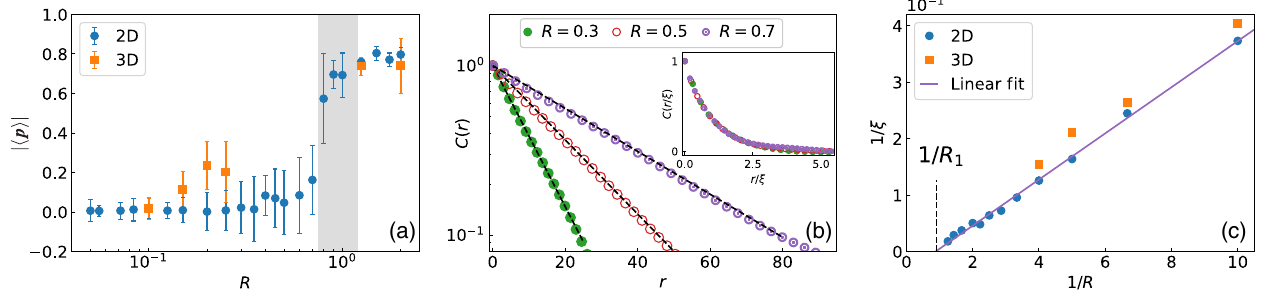
FIG. 5. (a) Variation of the order parameter jh p ij with R for our 2D and 3D simulations (see Table I), with the shaded region indicating the transition regime around R ¼ R 1 as predicted by the linear stability analysis. For each data point, the spatiotemporal average is calculated from about 60 statistically independent realizations, and the standard deviation about the average is shown as the error bar. (b) Semilog plot of the correlation function C ð r Þ versus r for R ¼ 0 . 3 , 0.5, and 0.7 ( R < R 1 , runs SPP6 – 8). Dashed black lines indicate the exponential fit. Inset: collapse of steady-state correlation function when distance is scaled with the correlation length. (c) Plot of inverse correlation length 1 = ξ versus 1 =R . The continuous purple line shows the linear fit to 2D data. Note that from the intercept of the linear fit on the horizontal axis we conclude that the correlation length diverges around R ¼ R 1